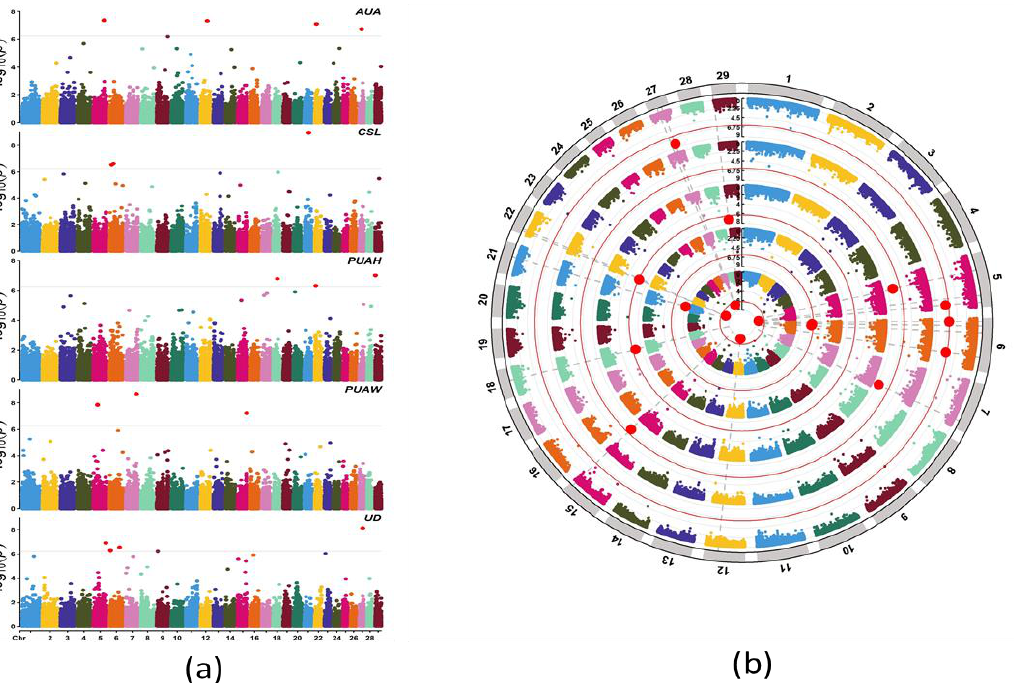
Figure 3. The quantile–quantile plots of the five udder traits from the GWAS in Holstein cow. The separation between the observed and expected values was analyzed using QQ plots. The null hypothesis indicated no relationship with the red lines. Deviation of the expected p -value showed that the population stratification was adequately controlled in the tails for every trait. The red dot significant SNPs indicate the threshold value. Table 3. GWAS significant SNPs associated with udder structure conformation traits in Holstein cattle.